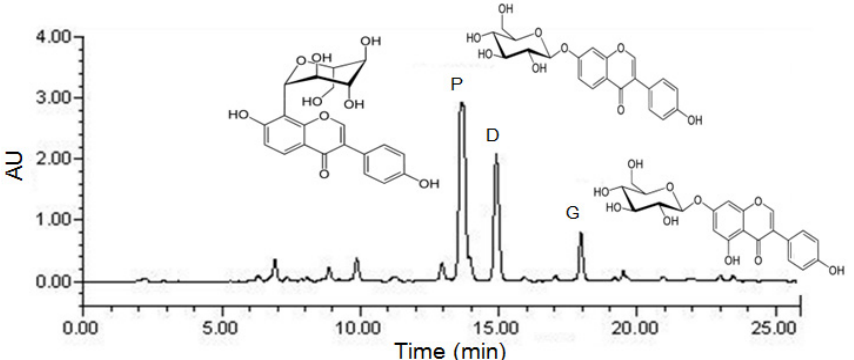
Figure 1. Preparative HPLC chromatography of Total Isoflavones from P. lobata (TIPL).